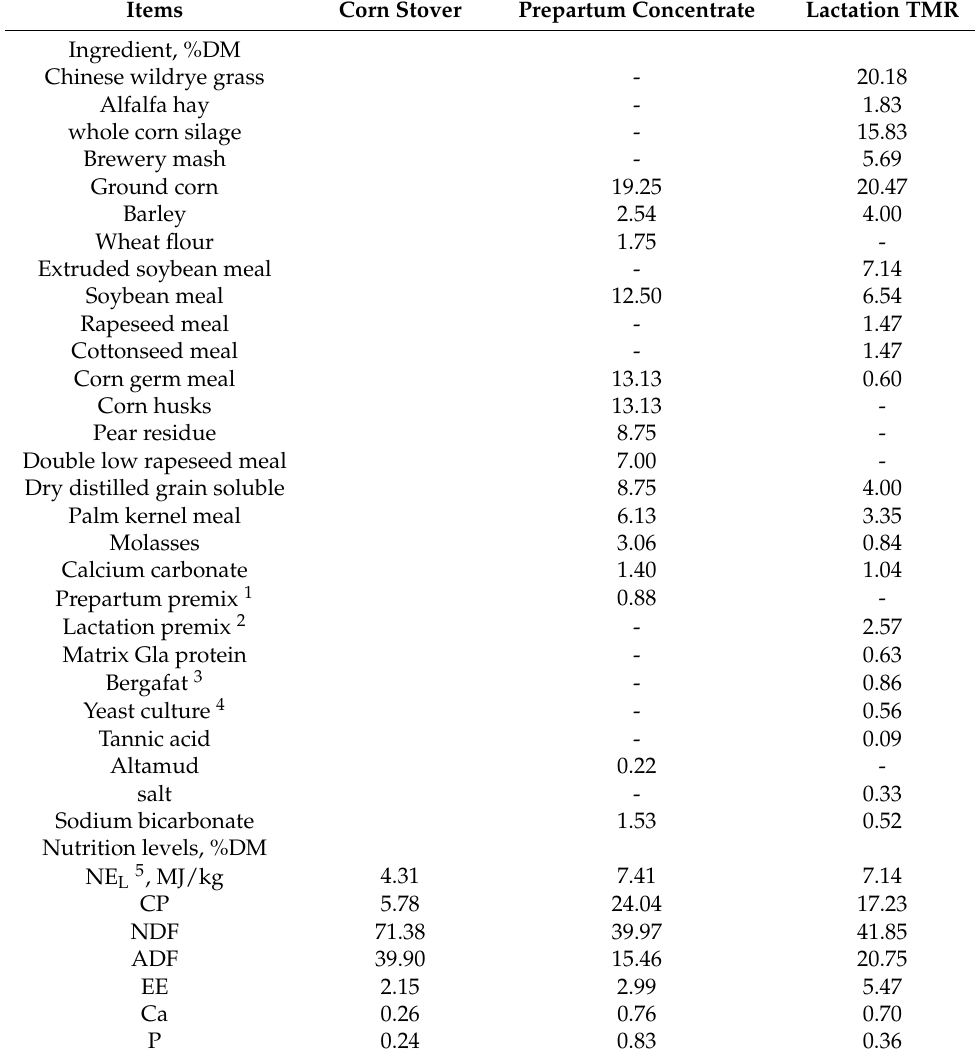
Table 1. Dietary composition (dry matter